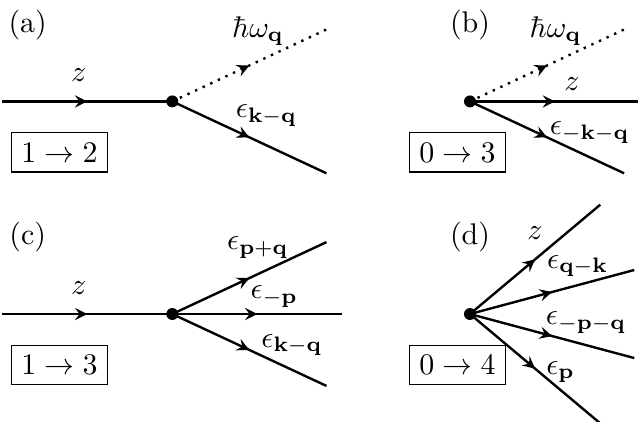
Figure 3: Different processes contributing to the fermionic self-energy. The full lines depict quasiparticles, while the dotted lines are collective modes. Both (a) and (b) result from the residue of the poles of the self-energy integrand of Eq. (16), and describe the emission of a collective mode by a quasiparticle and the spontaneous emission of two quasiparticles and a collective mode from the vacuum. The diagrams in (c) and (d) describe four-fermion processes, coming from the contribution of the branch cut. Only in the weak-coupling limit can an explicit coupling amplitude be written down for these